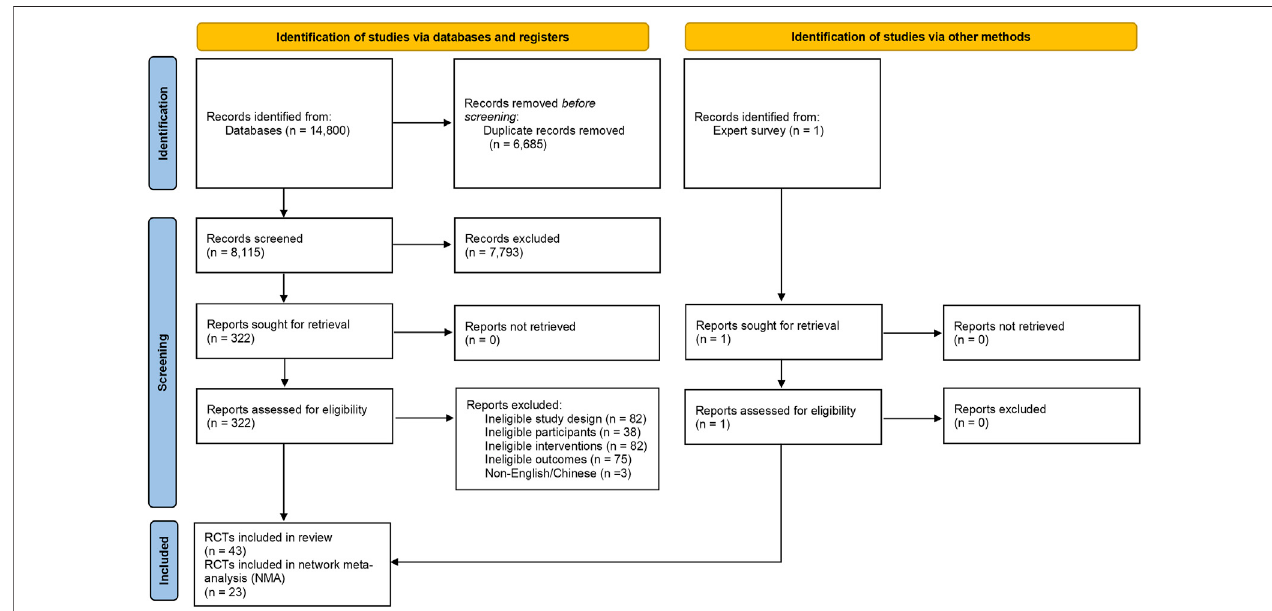
FIGURE 1 | PRISMA fl ow